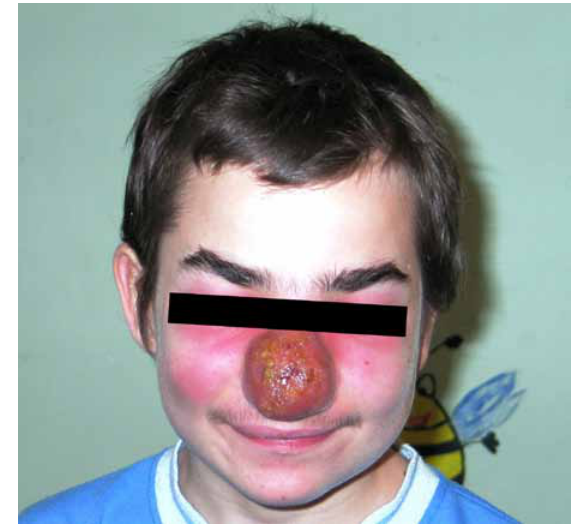
Figure 1. Facial cellulitis - inflammatory infiltration, blistering and oozing erosions.